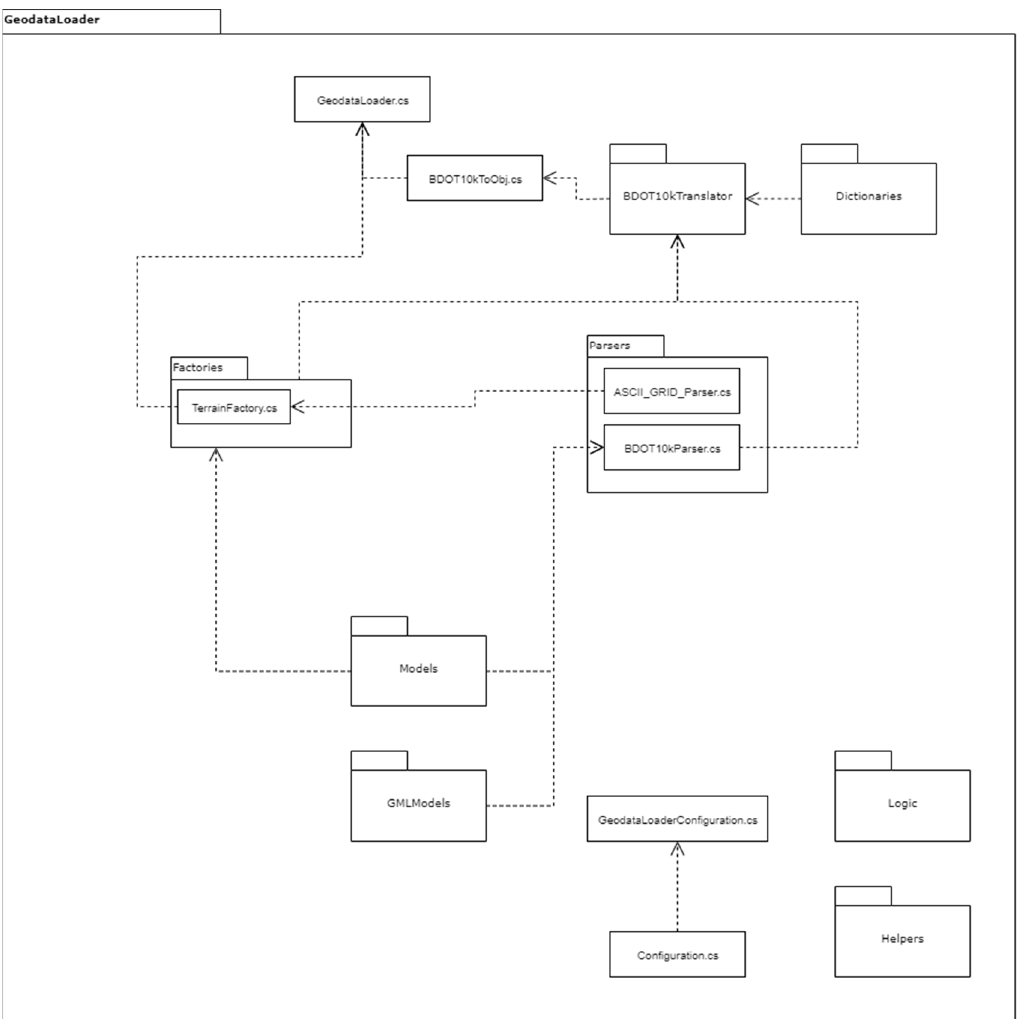
Figure 4. General scheme for importing geodata into the Cities: Skylines game engine.